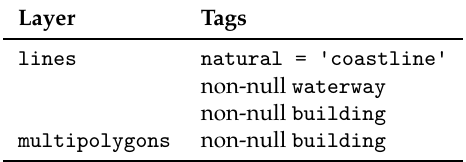
Table 1. GeoFabrik ontology layers and associated metadata tags used in analysis.